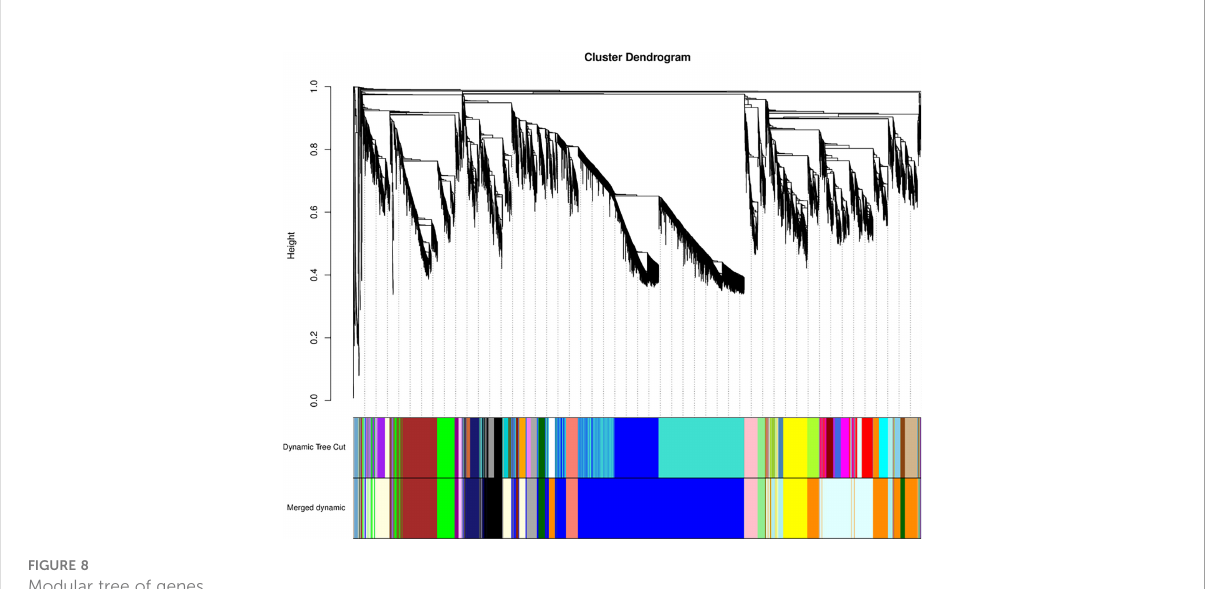
FIGURE 8 Modular tree of genes.